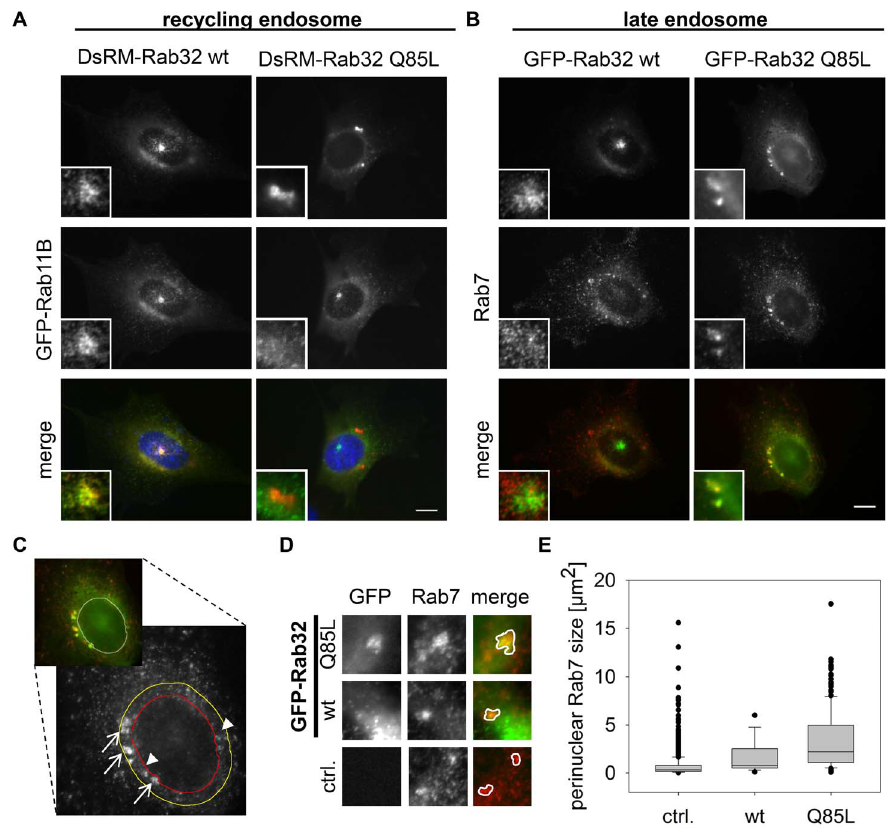
Figure 4. Co-localization analysis of Rab32 wt and the constitutively active mutant Rab32 Q85L with different endosomal markers. (A) NIH3T3 cells were co-transfected with plasmids encoding the recycling endosome marker GFP-Rab11B and DsRed-Monomer-Rab32 wt or DsRed- Monomer-Rab32 Q85L, fixed and analyzed by fluorescence microscopy. Scale bar=10 m m. (B) Cells were transfected with plasmids encoding for GFP- Rab32 wt or GFP-Rab32 Q85L followed by fixation and subsequent immunofluorescence staining of Rab7. Scale bar=10 m m. (C–E) NIH3T3 cells expressing either GFP-Rab32 wt or GFP-Rab32 Q85L were fixed and stained for Rab7. (C) Microscopic analysis of GFP-Rab32 Q85L that co-localized with endogenous Rab7 (arrows) in the perinuclear area. Non co-localizing Rab7 was indicated by arrowheads. The perinuclear area was defined by the red (outlines nucleus) and the yellow line (outer border for perinuclear area). The image illustrates the cellular area used for the following analysis. (D) Rab7 perinuclear aggregates co-localizing with GFP-Rab32 wt or GFP-Rab32 Q85L and non co-localizing ones. ctrl.=control (untransfected IHKE-1 cells) (E) Quantification of perinuclear Rab7-positive structures. ctrl. (control): perinuclear Rab7 in untransfected cells; wt/Q85L: perinuclear Rab7 co- localizing with GFP-Rab32 constructs. control/Rab32 wt/Rab32 Q85L: n=1660/18/167 structures in 67/18/60 cells, 1/1/3 independent experiments. Statistical significance was tested by a Student’s T-test: p control-wt =0.02; p control-Q85L , 0.005; p wt-Q85L =0.02. Scale bar=10 m m.